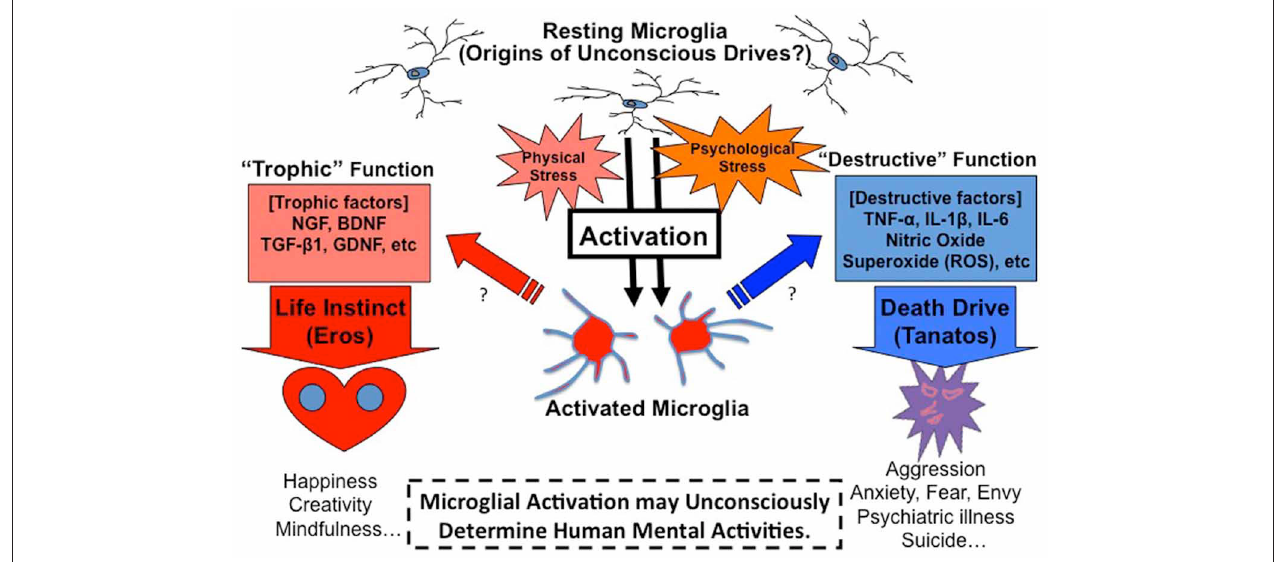
FIGURE 2 | Microglia theory of unconscious drives. Microglia may act as the origin of unconscious drives in the mind. Microglia play the role of a double-edged sword in the brain. Microglia release not only maladaptive factors such as TNF- α but also protective factors such as BDNF, which means that microglia are alternately both bad and good actors in the brain. The direction and strength of microglial activation may be the origin of Freud’s two essential drives of death (tanatos) and life (eros). “Destructive” function of microglia may play an essential